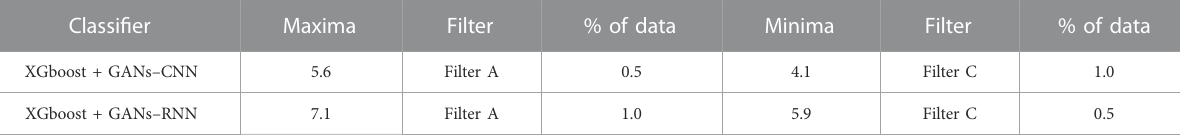
TABLE 1 Enrichment Ratios of ADORA2A on the original dataset with no feature selection with training size of 30%.